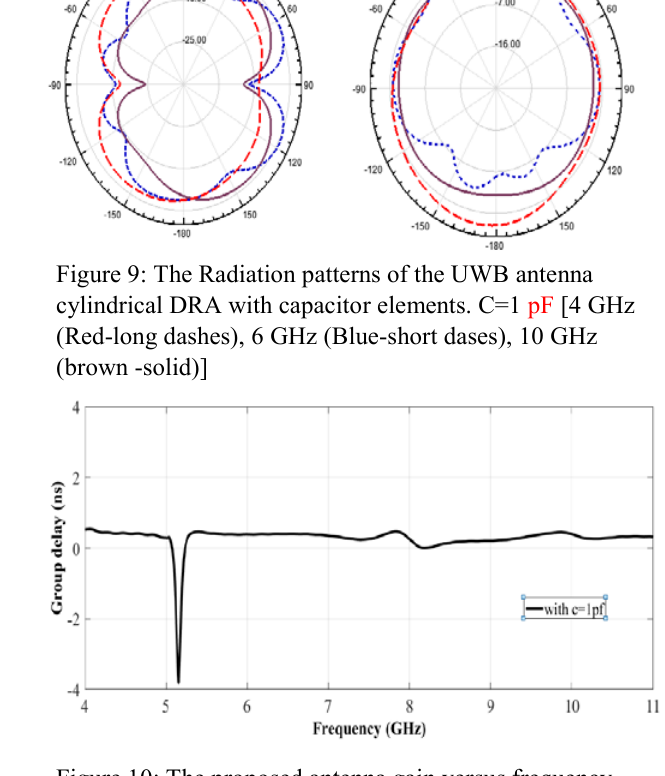
Figure 10: The proposed antenna gain versus